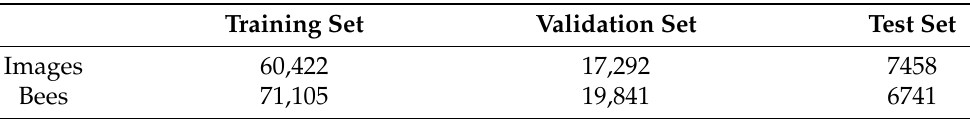
Table 2. The training data.